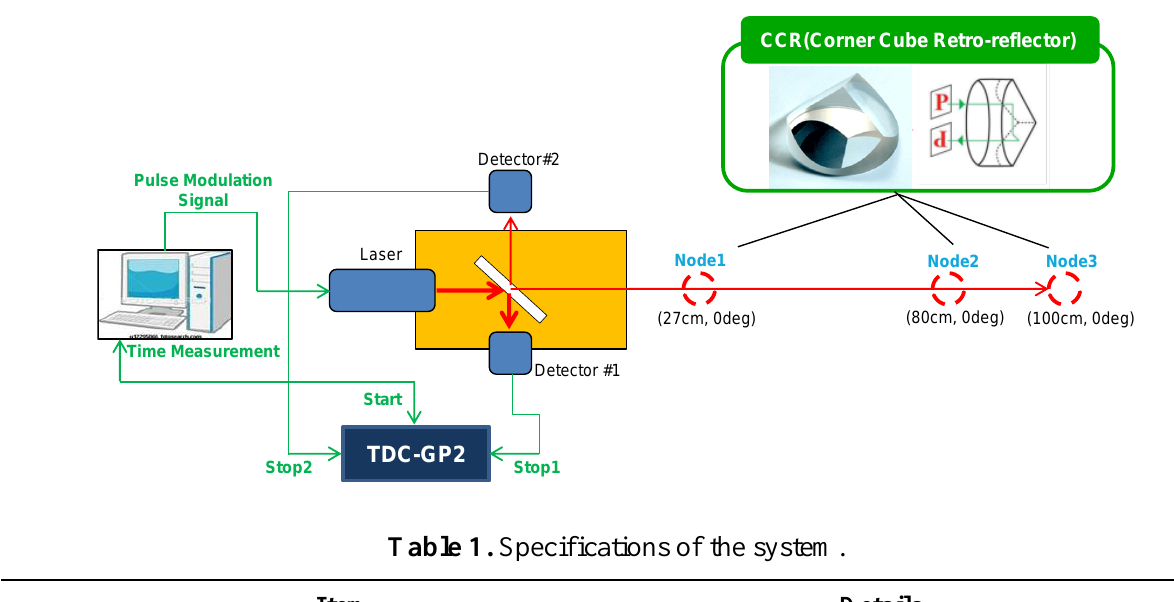
Figure 5. Node position for the evaluation of the distance measurement performance.